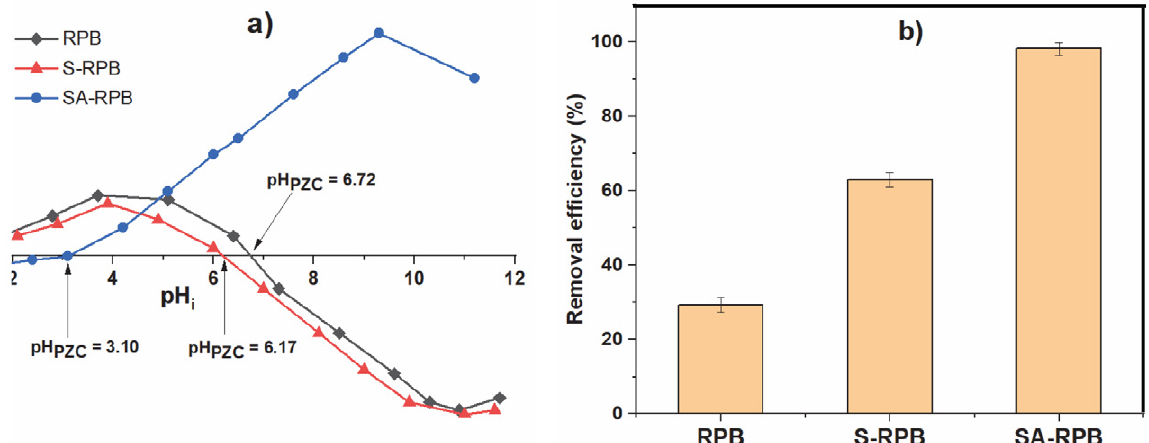
Fig. 3. (a) Plots of point of zero charges of RPB, S-RPB, and SA-RPB (1.0 g/L adsorbent at different pH values); (b) percentage removal efficiency values for MB on RPB, S-RPB, and SA-RPB samples (150 mg/L MB at 6.5 pH